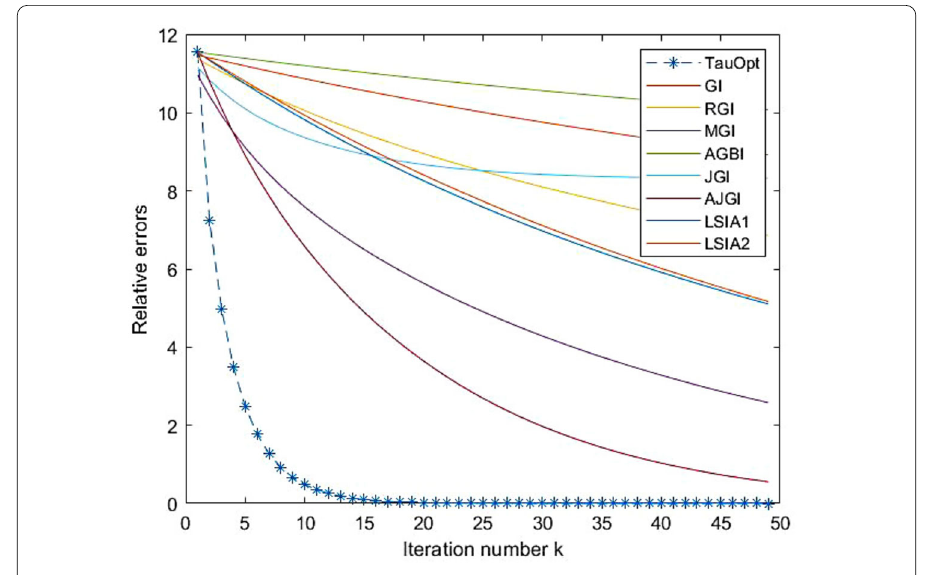
Figure 5 Relative errors for Ex.